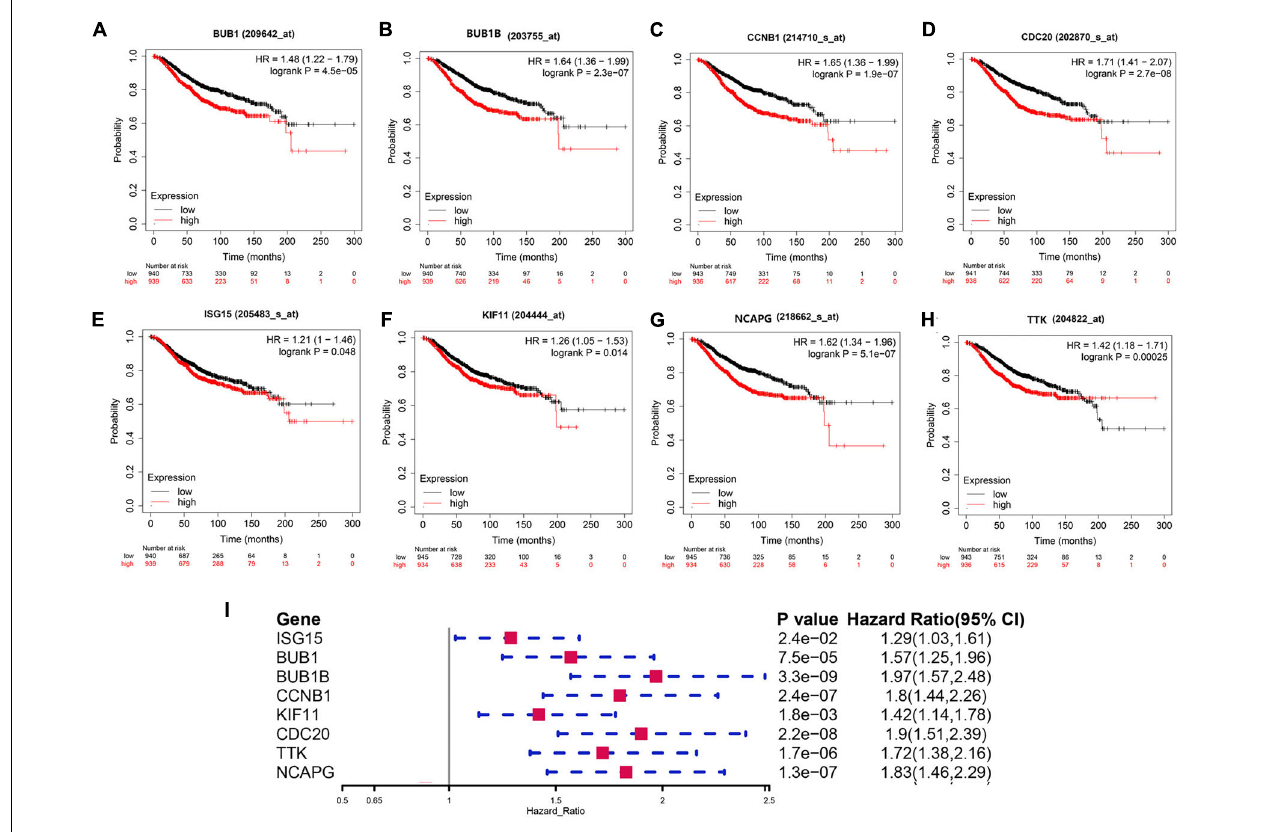
FIGURE 6 | Prognostic significance of validated hub genes in BC. (A–H) Validated hub genes with significant prognostic value for OS in BC are shown: (A) BUB1 , (B) BUB1B , (C) CCNB1 , (D) CDC20 , (E) ISG15 , (F) KIF11 , (G) NCAPG , and (H) TTK . (I) Prognostic value of these eight hub genes for 5-year OS in BC.